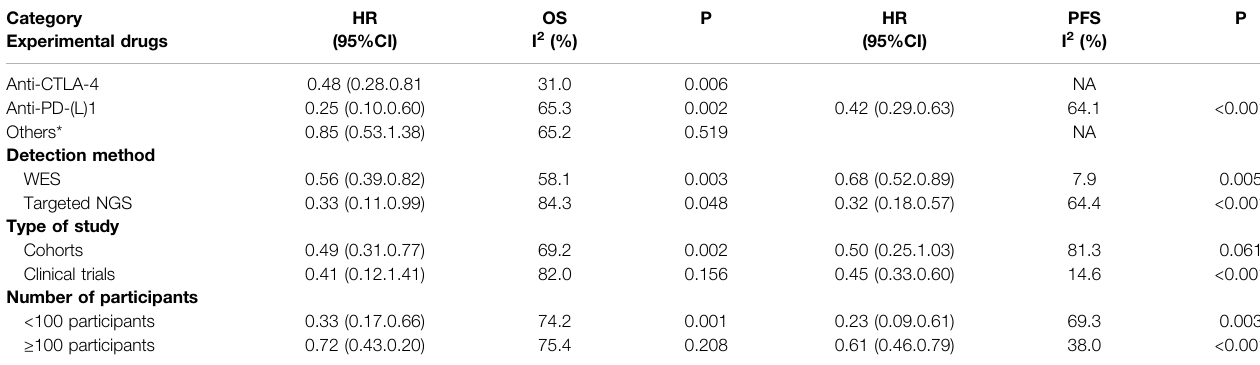
TABLE 3 | Subgroup analysis of predictive value of TMB for ICI treatment on melanoma. Category Experimental